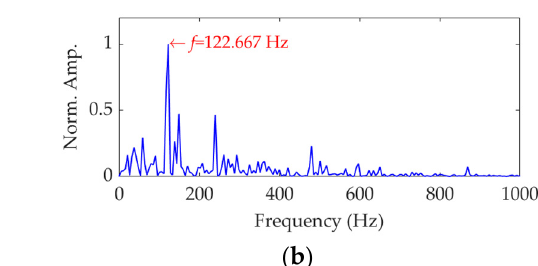
Figure 9. The target mode obtained by VMD: ( a ) time − domain waveform and ( b ) SES.